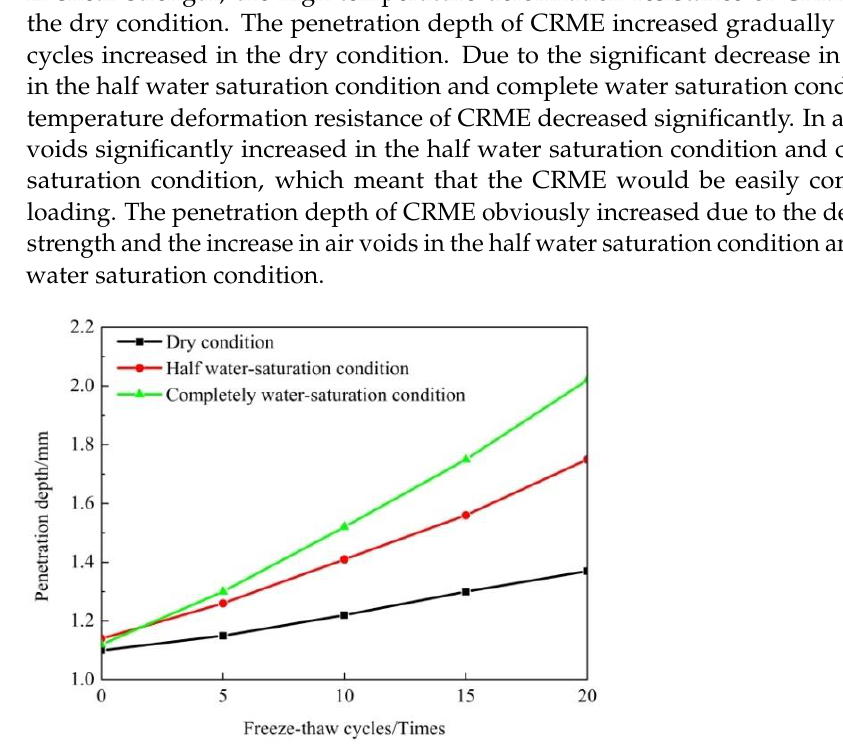
Figure 4. Shear strength under freeze – thaw cycles with different water saturation conditions.